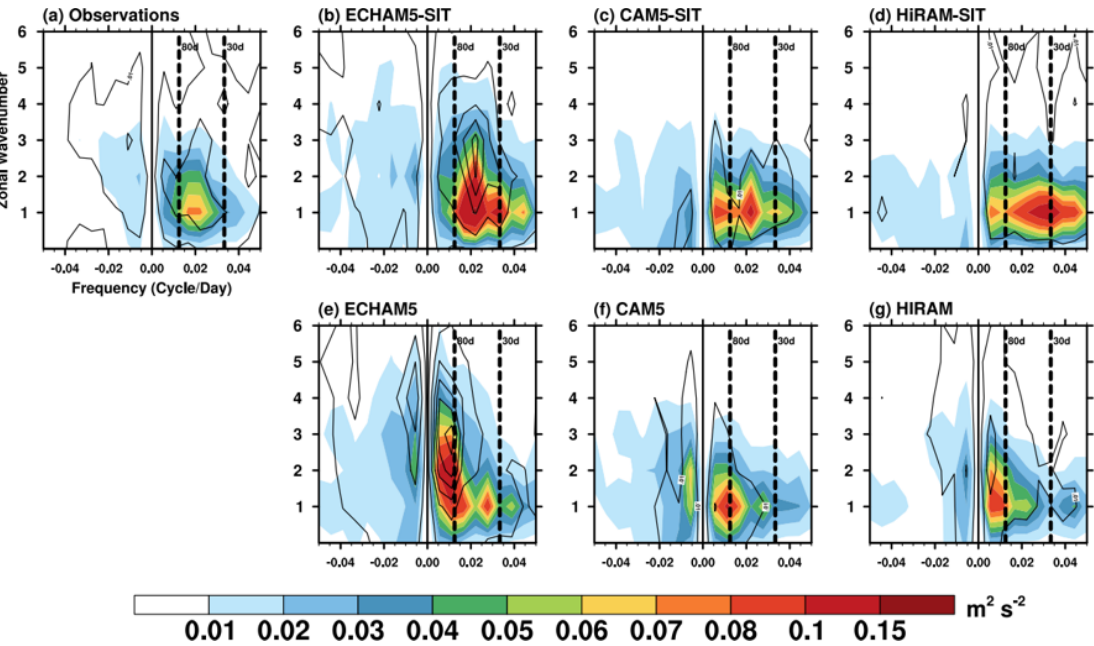
Figure 1. Wavenumber–frequency spectra for equatorial 850hPa zonal wind (shading; m 2 s − 2 ) and precipitation (contours;mm 2 d − 2 ) over